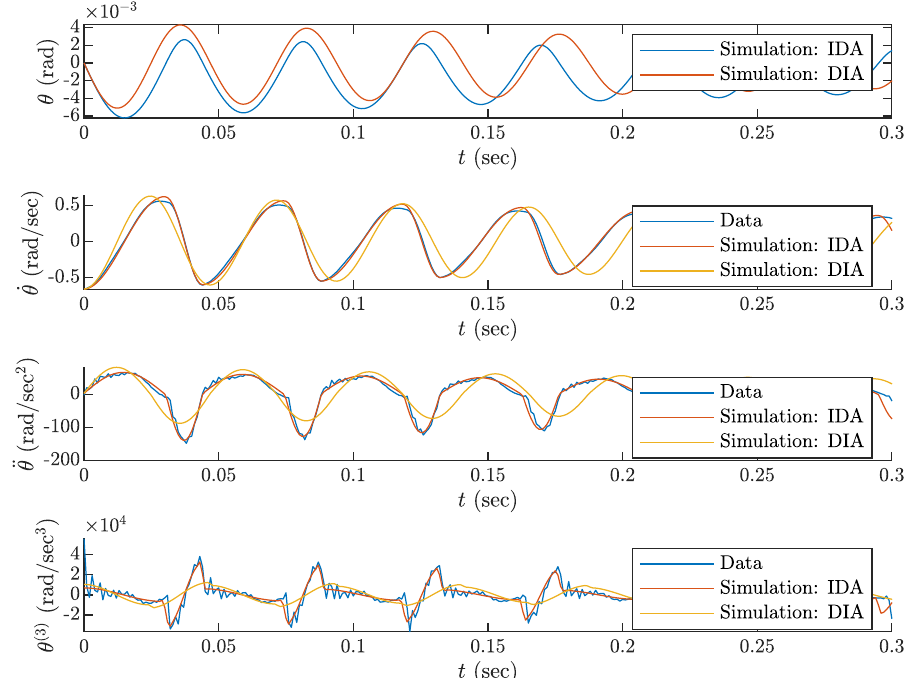
Figure 9. Fragment of time-domain signals representing various derivatives of angular displacement θ with comparison between real signals and two models obtained with the described identifica- tion approaches.